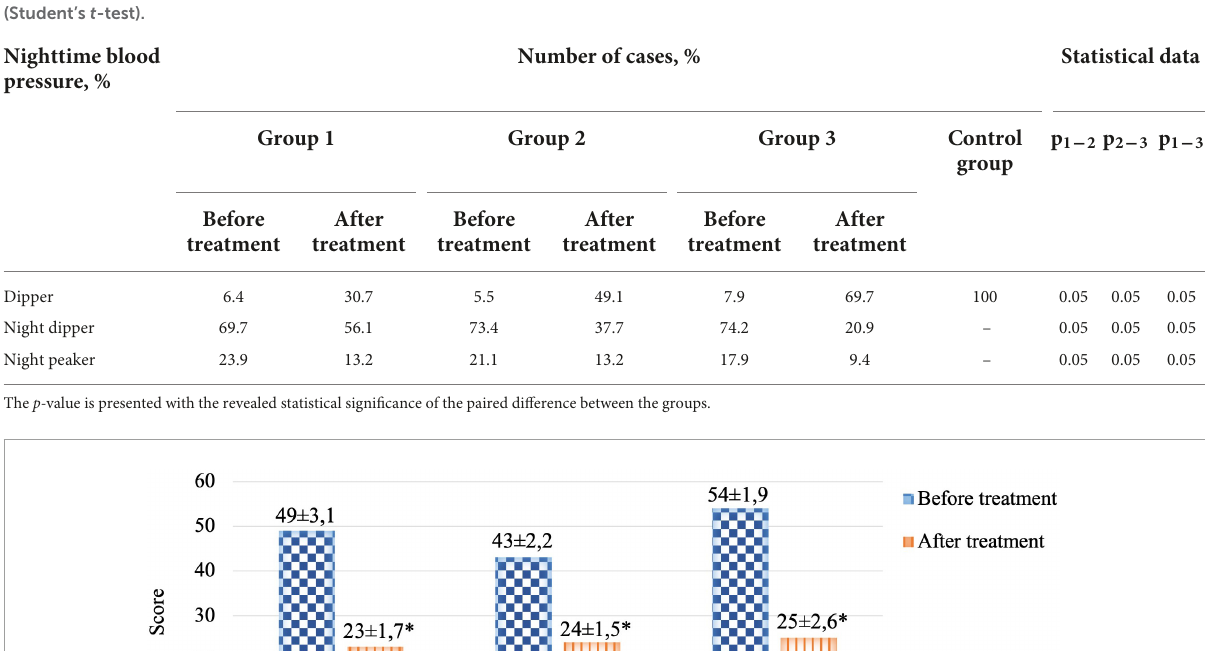
FIGURE3 Circadian excretion of urinary 6-hydroxymelatonin sulfate before and after treatment in the study groups.